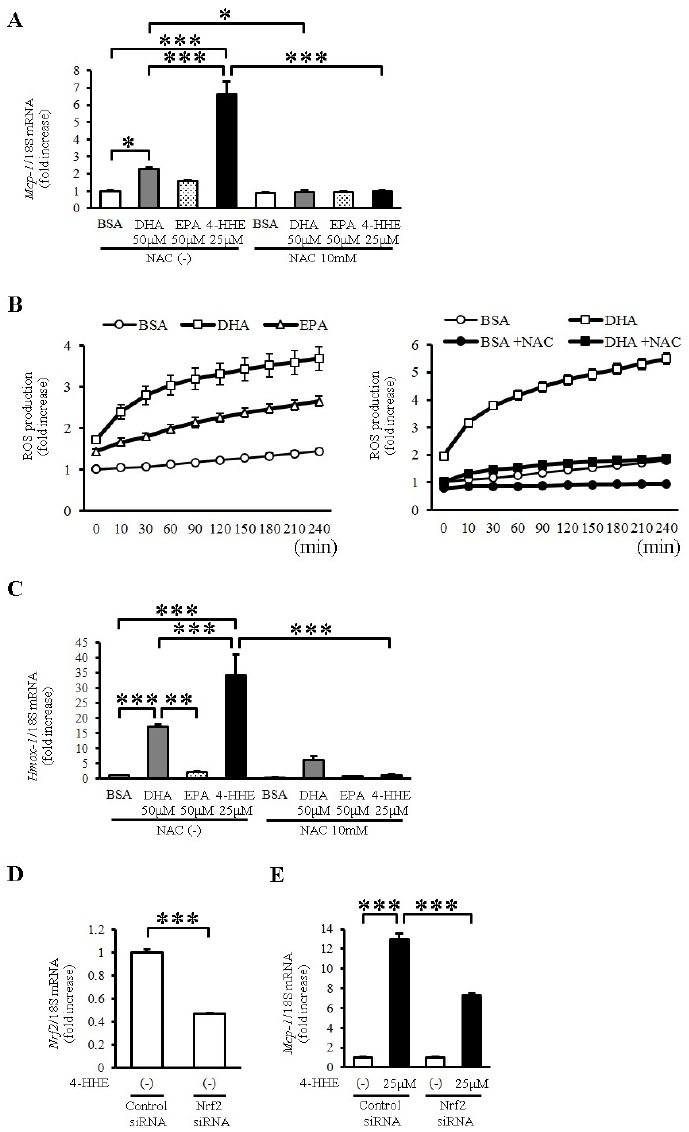
Figure 3. DHA-derived 4-HHE induces Mcp-1 expression partially through the oxidative stress-induced Nrf2 pathway in VSMCs. ( A , C ) VSMCs were treated with N -acetyl- L -cysteine (NAC; 10 mM) for 1 h before incubation with BSA, DHA (50 μ M), EPA (50 μ M) or 4-HHE (25 μ M) for 6 h. Relative mRNA expression of Mcp-1 ( A ) and Hmox-1 ( C ) in VSMCs was quantitated using RT-qPCR. Results were normalized against 18S rRNA and expressed as fold increase over control. ( B ) Reactive oxygen species (ROS) production was measured by 2’7’-Dichlorodihydrofluorescein diacetate (H 2 DCFDA). BSA, DHA (50 μ M) or EPA (50 μ M) was added for 4 h (left panel). BSA or DHA (50 μ M) was added with or without NAC (10 mM) for 4 h (right panel). ( D , E ) VSMCs were treated with Nrf2 siRNA (40 nM) or control siRNA (40 nM). After 24 h, VSMCs were treated with vehicle or 4-HHE (25 μ M) for 6 h. Relative mRNA of Nrf2 ( D ) and Mcp-1 ( E ) was quantitated using RT-qPCR. Values represent the mean ± SE of three independent experiments ( n = 9; A , C ); a single experiment ( n = 3; B ); and two independent experiments ( n = 6; D and E ). * P < 0.05, *** P < 0.001, compared with the corresponding control.